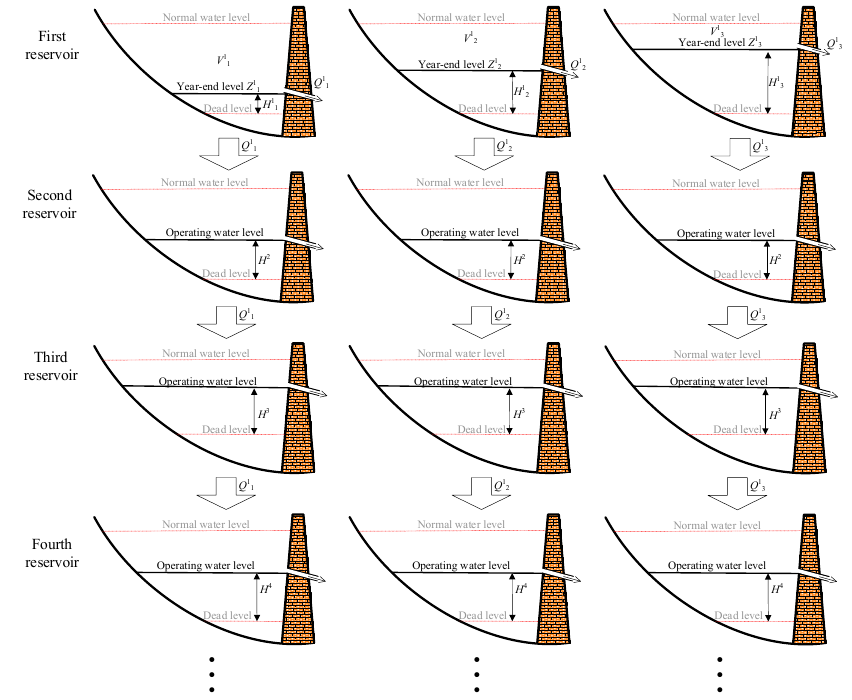
Figure 4. Schematic diagram of different year-end water levels of multi-year regulating reservoir in joint operation.